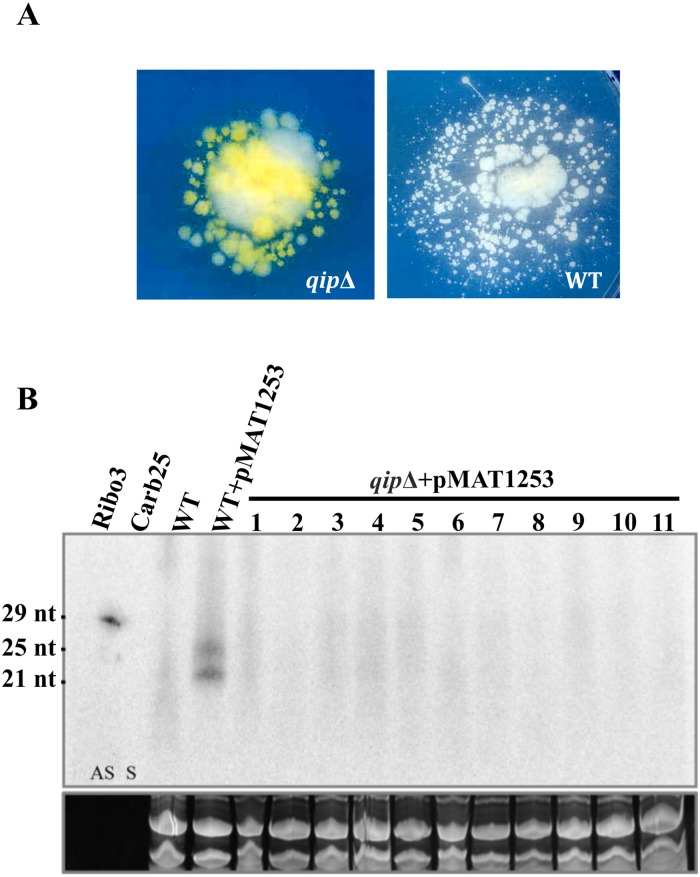
Transgene hairpin silencing is defective in qip null mutant.(A) Phenotype of the descendants of white colonies obtained from transformation of wild type (R7B, right) and the qipΔ mutant (left) with plasmid pMAT1253, which expresses a carB mRNA hairpin. The color of the colonies was analyzed after 48 hours growth on YNB media in the light. (B) sRNA enriched samples (50 μg) from 11 non-silenced transformants in the qipΔ background carrying pMAT1253 were obtained after 48 hour incubation in liquid YNB media pH = 4.5. A carB probe that specifically detects antisense RNA was used for hybridization in a northern blot assay. A silenced transformant with the same plasmid but in a WT background was used as a positive control. Ribo 3 (antisense, AS) and carB25 (sense, S) primers were used as size and sense markers (see Methods). tRNA were stained with ethidium bromide and served as a loading control.